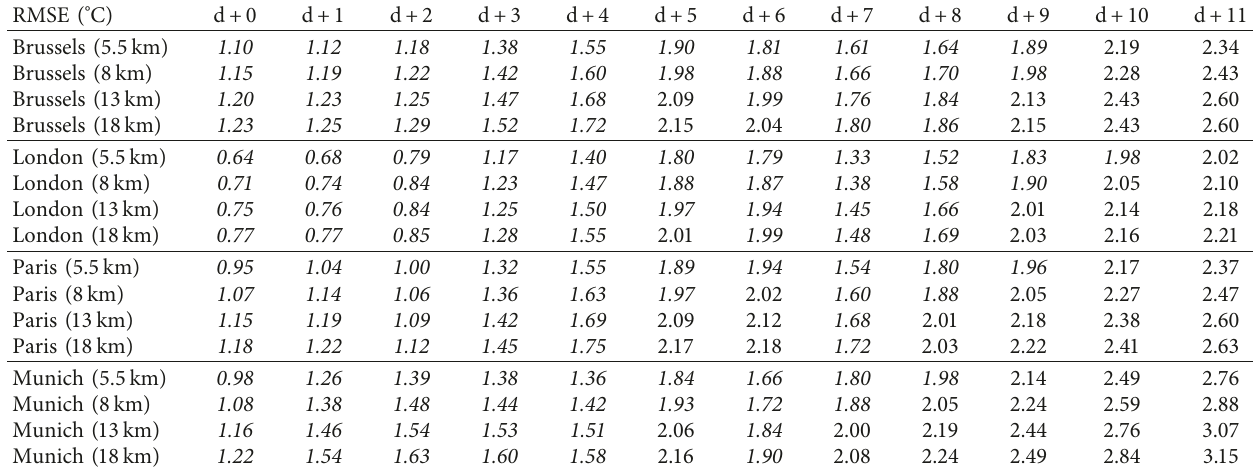
Table 4: RMSE of the e-kmf ™ temperature forecasts at different spatial resolutions and lead times over the European cities; values in italics depict a good forecast below the 2 ° C error